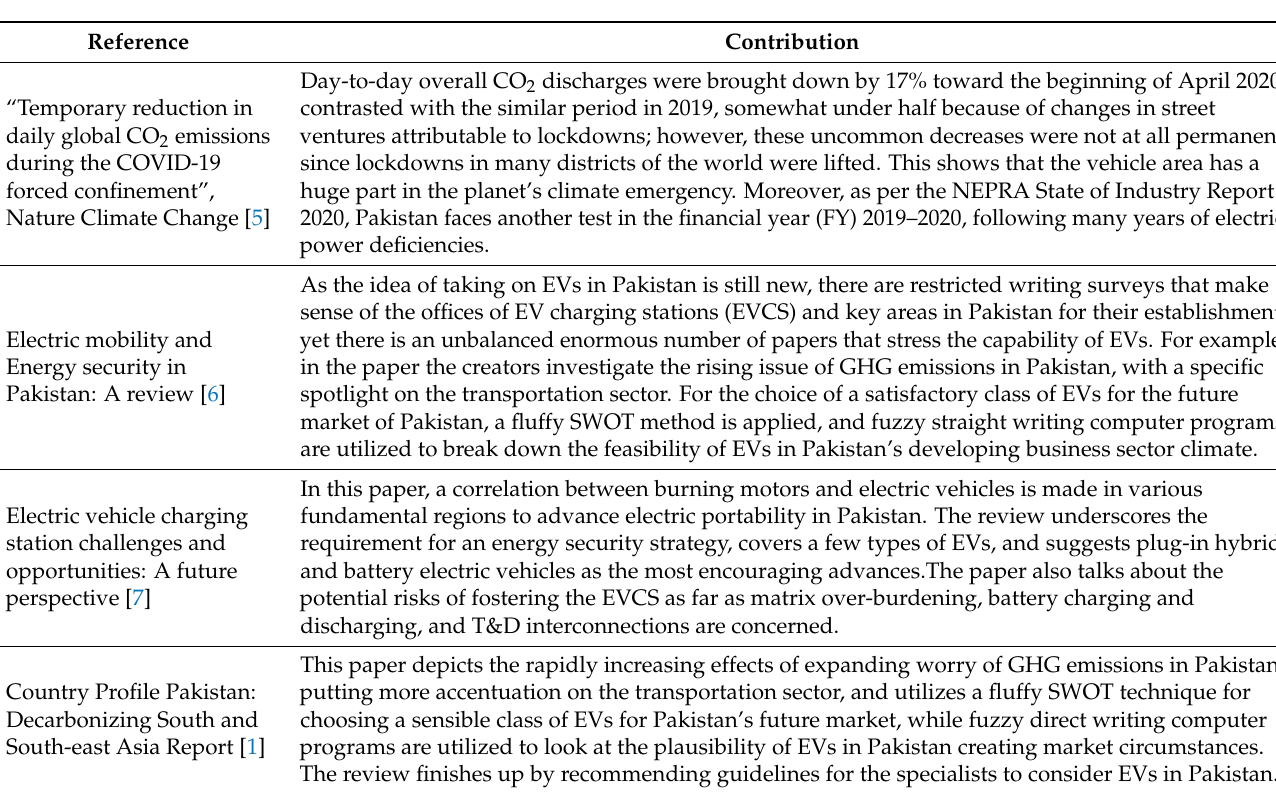
Table 1. Literature